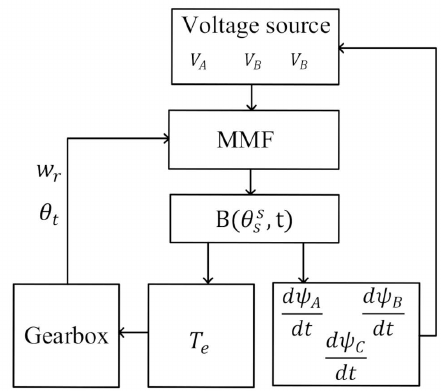
Figure 8. Model structure for Matlab coding. Table 1. Gearbox parameters [1].